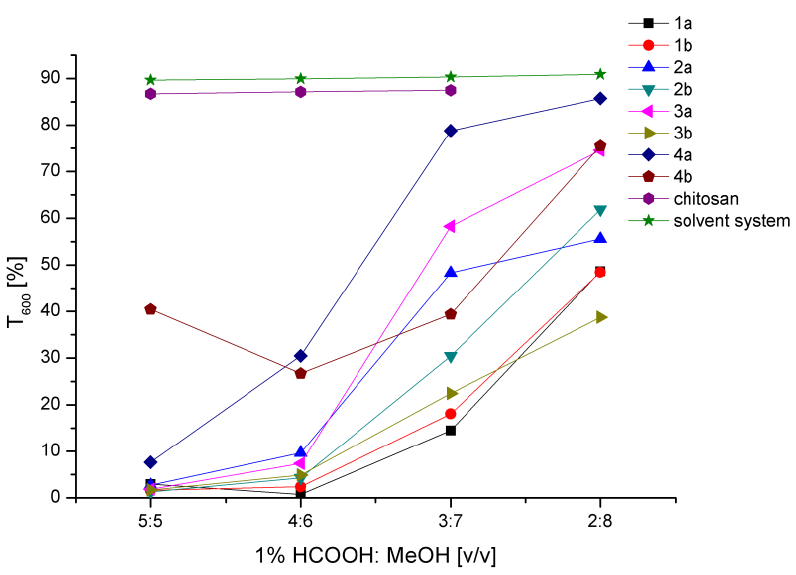
Figure 6. Transparency of chitosan derivatives solutions at di ff erent volume ratios of 1 wt% formic acid and methanol.